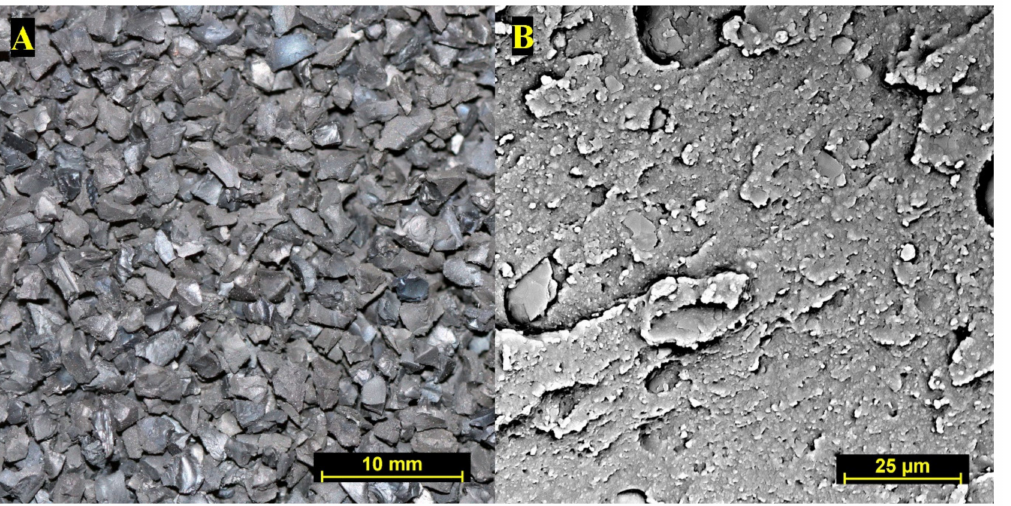
Figure 1. ( A )—Macroimage of studied rubber crumb; ( B )—SEM image of rubber crumb sample at 2500 ×